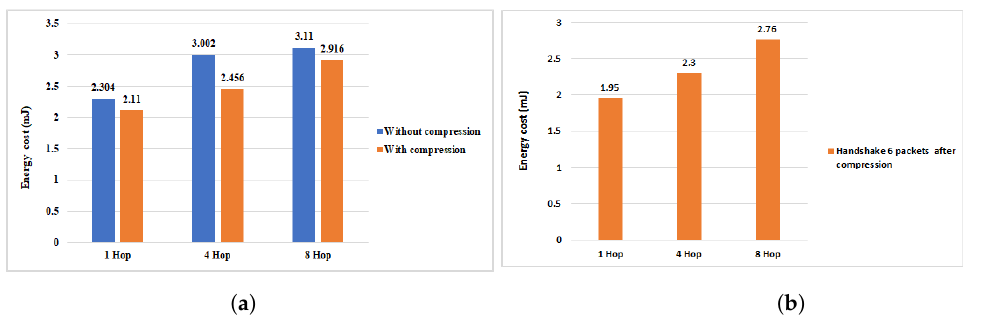
Figure 14. Energy communication costs of HIP DEX handshake packets including the signaling packets (6 packets). ( a ): Calculation done according to results obtained in [9]. ( b ): Results obtained with LC-DEX.